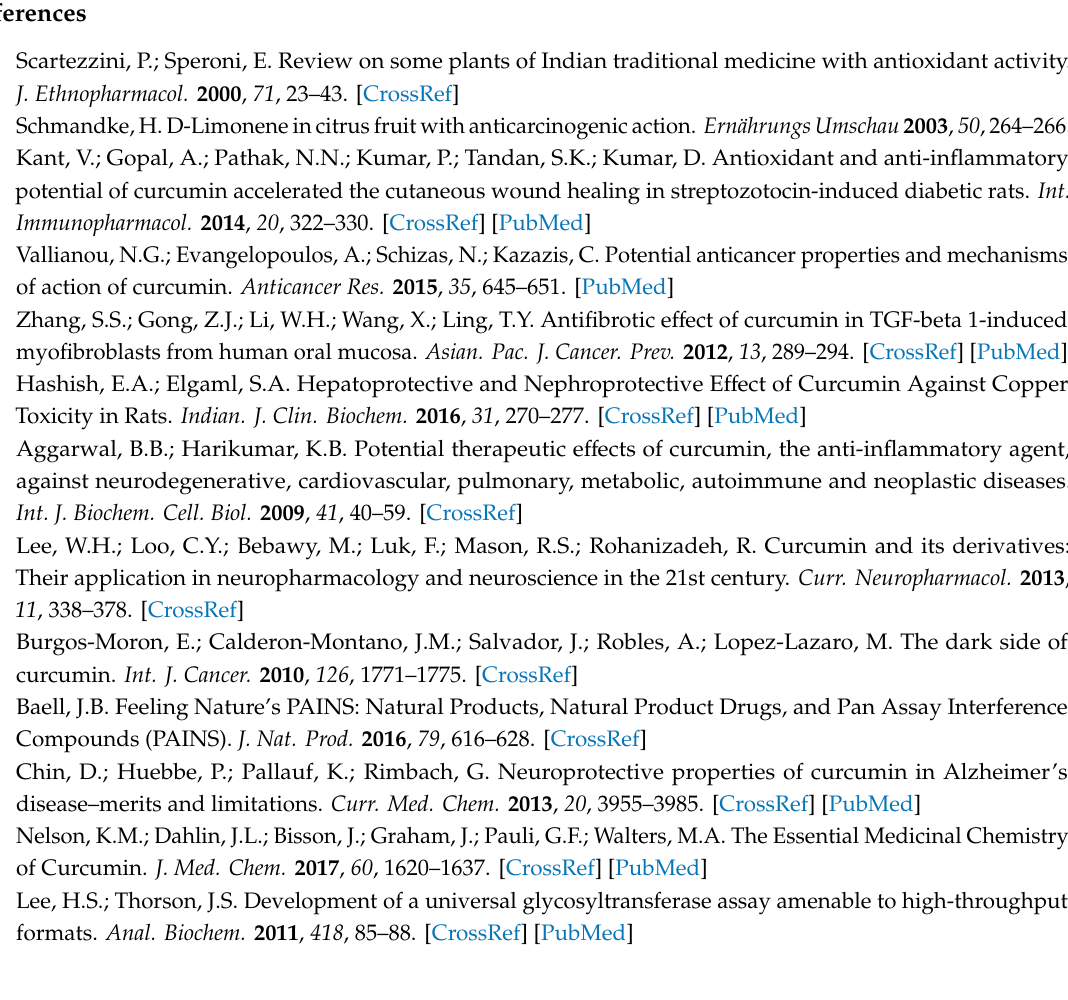
Figure S1: HPLC-QTOF-MS analysis of curcumin biotransformed by B. subtilis ATCC 6633; Figure S2: Biotransformation of Curcumin 1 (a) and its two analogues 2 (b) and 3 (c) by the purified BsGT1 ; Figure S3: Biotransformation of curcumin 1 (a) and its two analogues 2 (b) and 3 (c) by the purified BsGT2 ; Figure S4: 13 C NMR (a) and 1 H NMR (b) analysis of curcumin 4 (cid:48) -O- β -D-glucoside 1a ; Figure S5: 13 C NMR (a) and 1 H NMR (b) analysis of monoglucoside 2a ; Figure S6: 13 C NMR (a) and 1 H NMR (b) analysis of monoglucoside 3a ; Figure S7: Kinetic parameters of BsGT1 (a) and BsGT2 (b) toward